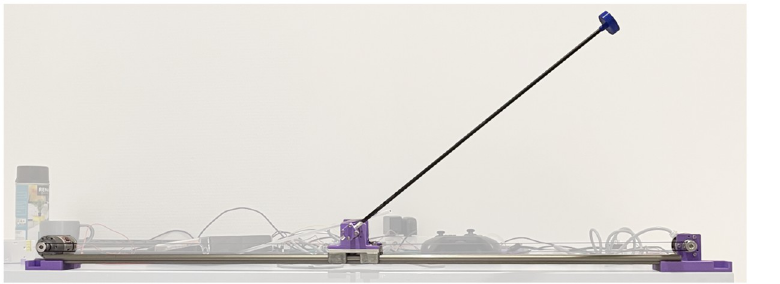
Fig 3. The experimental